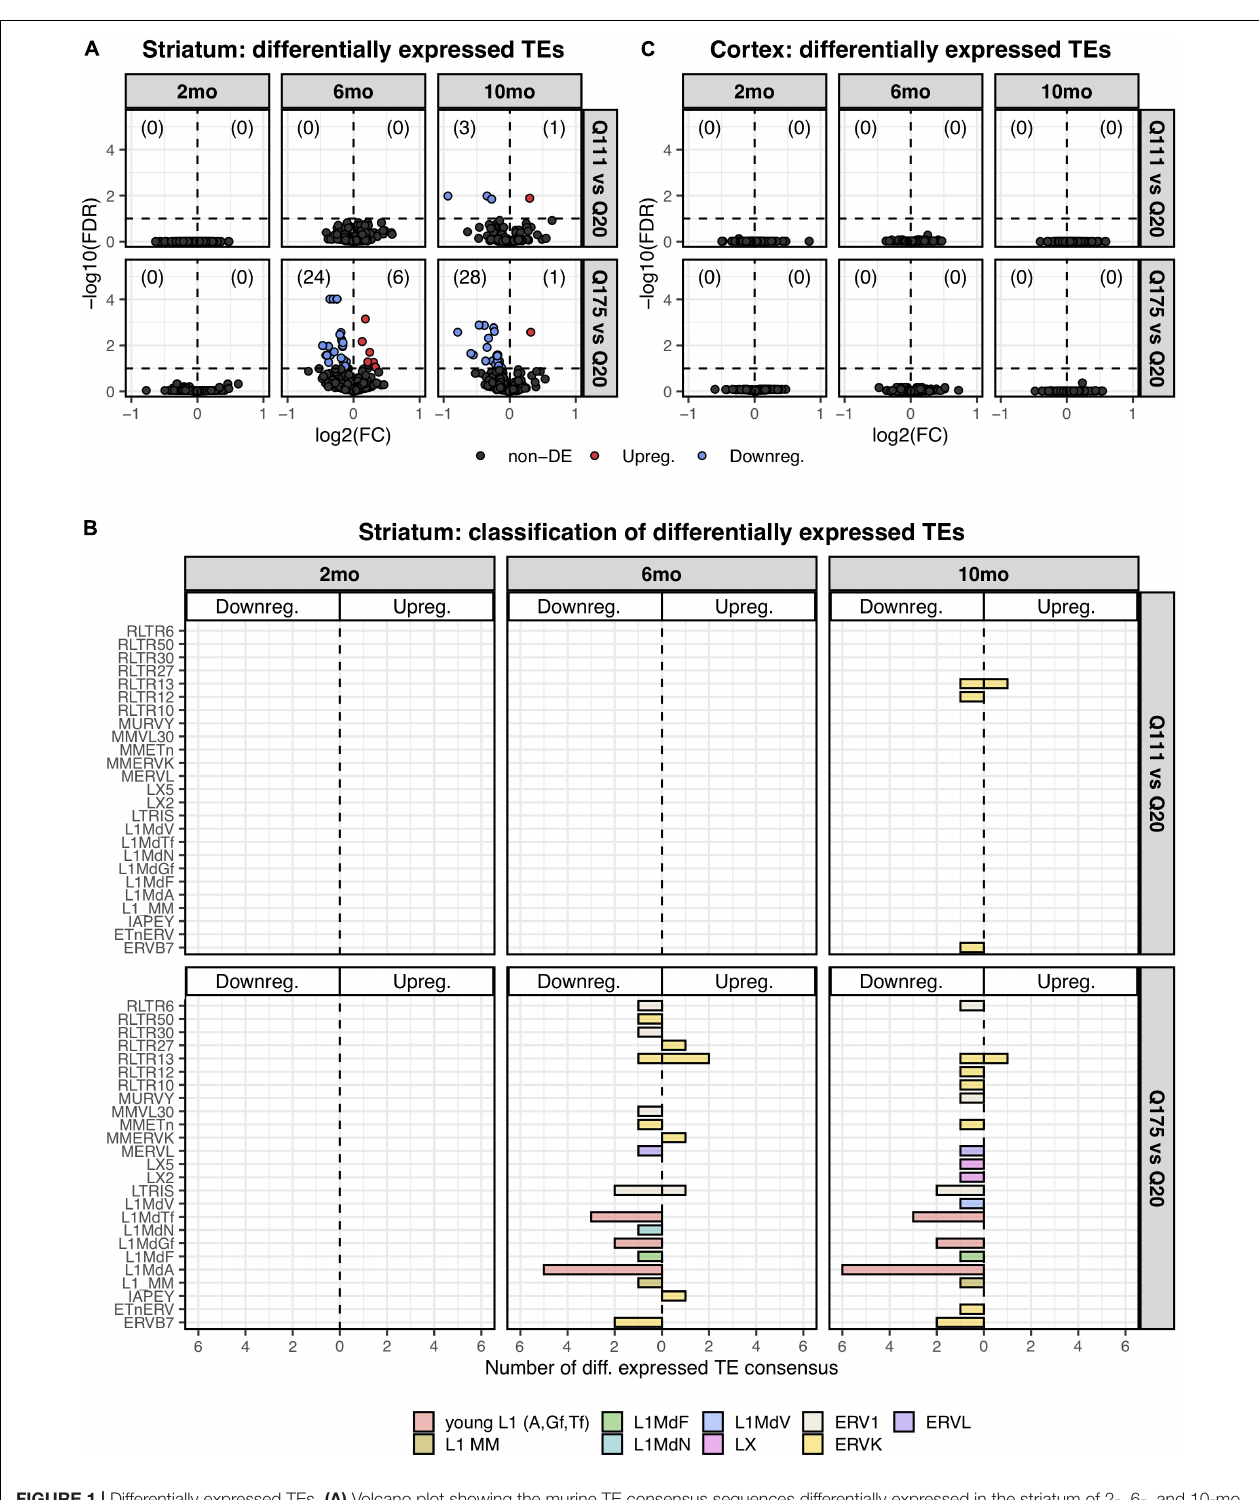
Frontiers in Cellular Neuroscience |